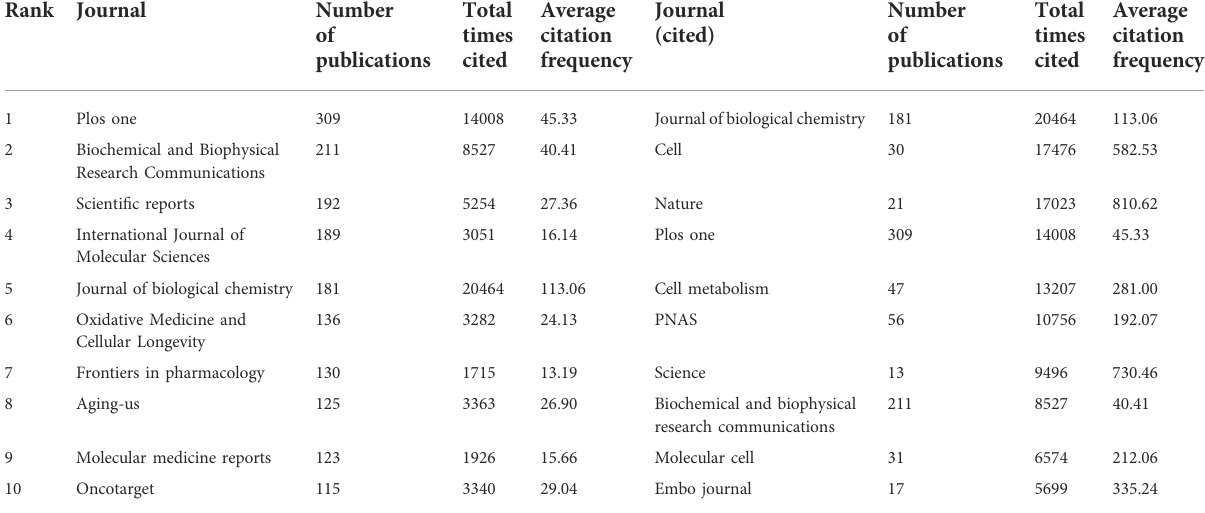
TABLE 5 Top ten journals with the largest number of publications and the most cited related to